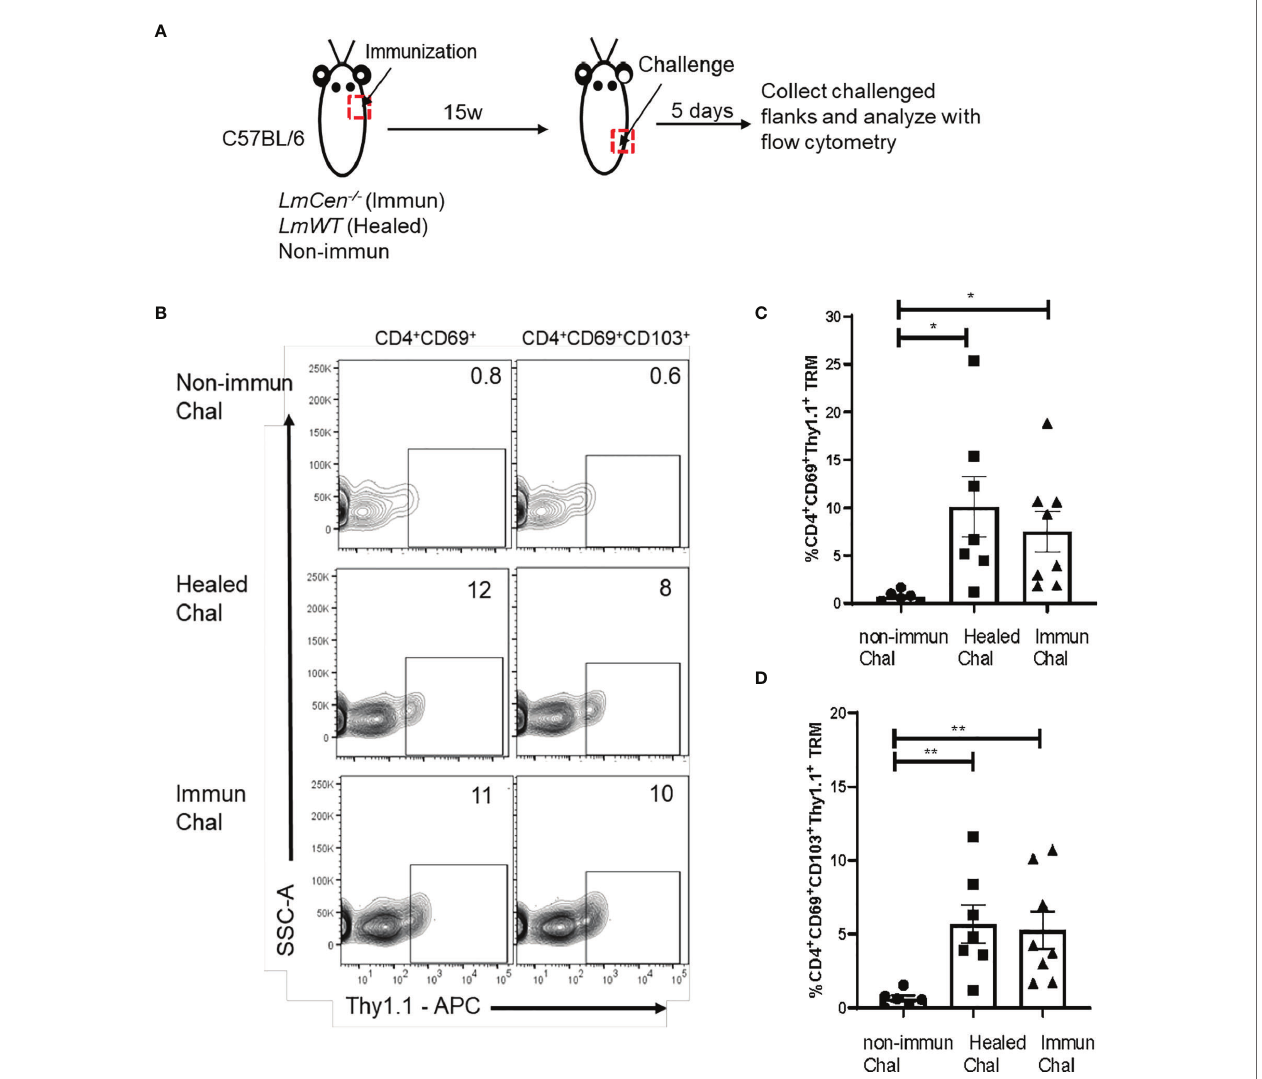
FIGURE 5 | Skin TRM cells from LmCen -/ – immunized mice produce IFN g in response to challenge. Non-immunized, healed, and immunized IFN g /Thy1.1 mice were challenged with LmWT parasite in the fl ank skin. T cells from challenged skin were isolated 5 days post-challenge, and cytokine production was assessed with fl ow cytometry analysis. (A) Schematic representation of the experiment. (B) Graph is representative of Thy1.1 staining on skin CD4 + TRM cells (CD3 + CD4 + CD44 + CD62L - CD69 + and CD3 + CD4 + CD44 + CD62L - CD69 + CD103 + ). (C, D) Expression of Thy1.1 surface marker, representing IFN g expression, was measured on (C) CD4 + CD69 + and (D) CD4 + CD69 + CD103 + TRM cells. Y axis represents a portion of skin CD4 + TRM cells expressing IFN g as a percentage of CD4 + CD69 + TRM population. Data shown are combined results from two independent experiments with n = 6 – 8 mice per group. Bars represent the means with SEM in each group. Statistical analysis was performed by unpaired two-tailed t-test (** p < 0.007, * p < 0.02). Chal, Challenged; w,